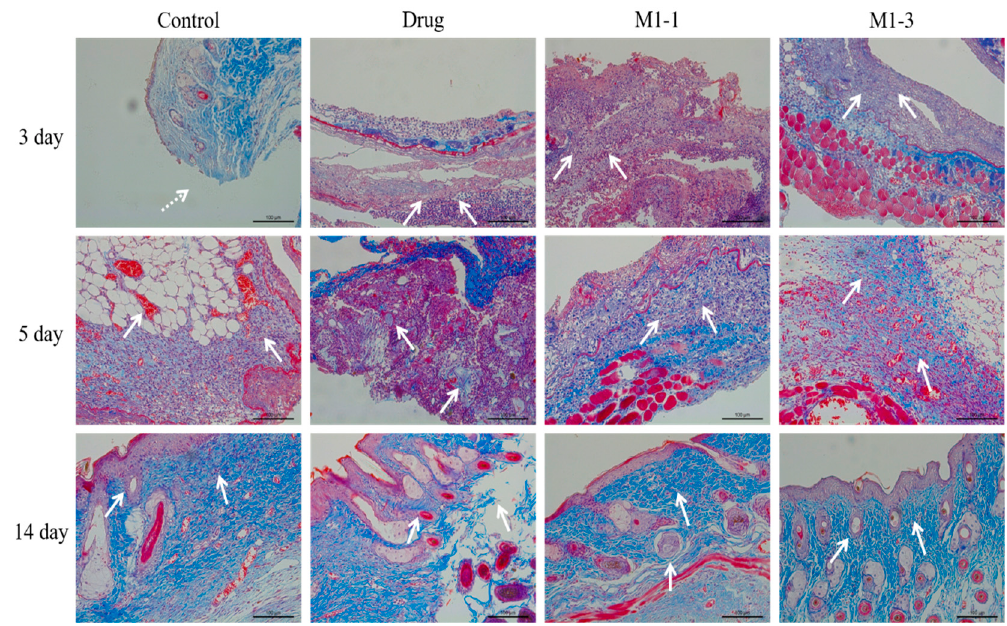
Figure 8. Masson staining of skin tissues at days 3, 5, and 14.